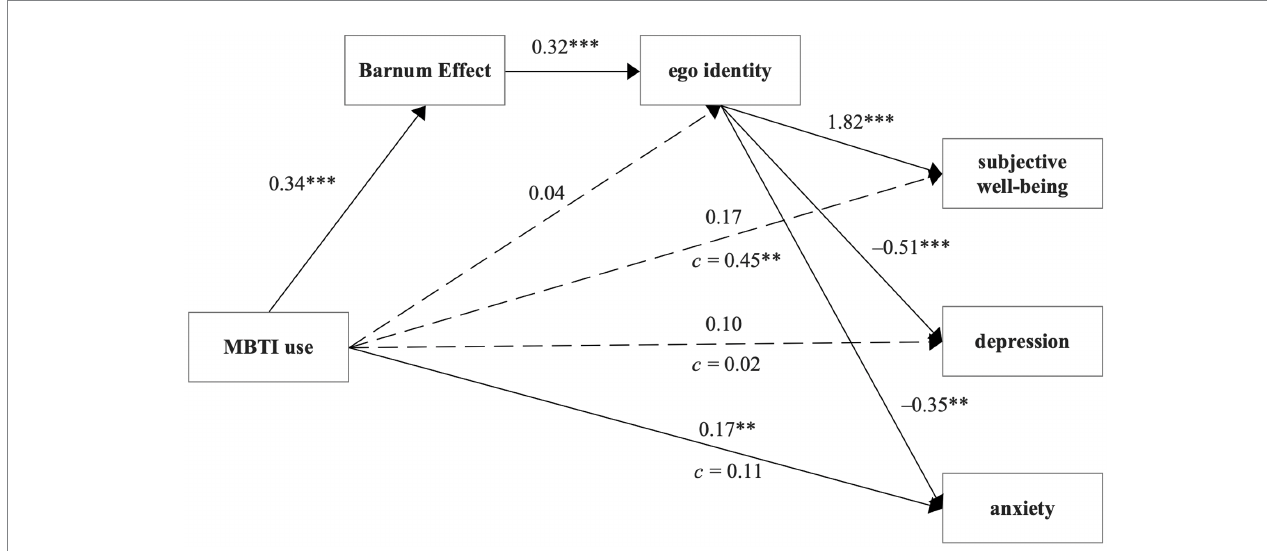
FIGURE 2 Sequential mediation models of Barnum effect and ego identity on the relationship between MBTI use and mental health (subjective well-being, depression, anxiety). N = 308, * p < 0.05, ** p < 0.01, *** p < 0.001 (two-tailed